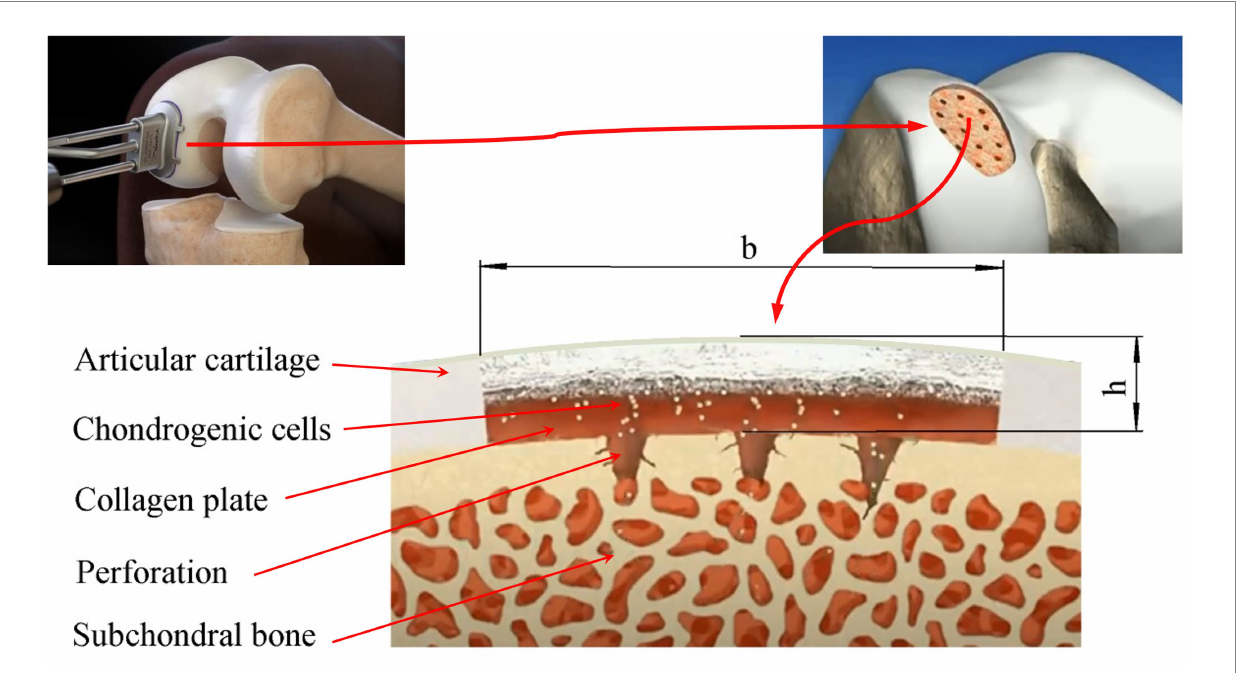
FIGURE 1 Scheme of the damaged area of the articular cartilage filled with a tissue-engineered structure based on a collagen plate placed on the subchondral bone: b , h -the maximum size and depth of the defect,